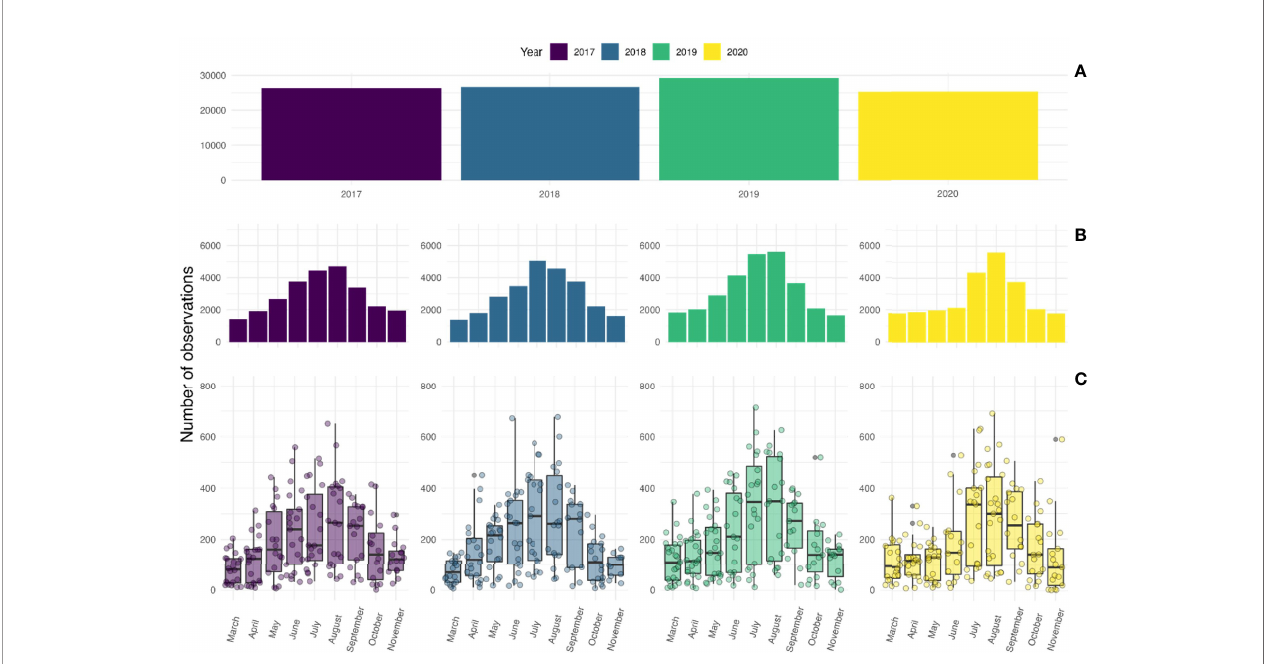
FIGURE 4 | Number of ship detections with the SUMO algorithm (A) yearly, (B) monthly, (C) daily in 2017, 2018, 2019 and 2020 on the French Mediterranean